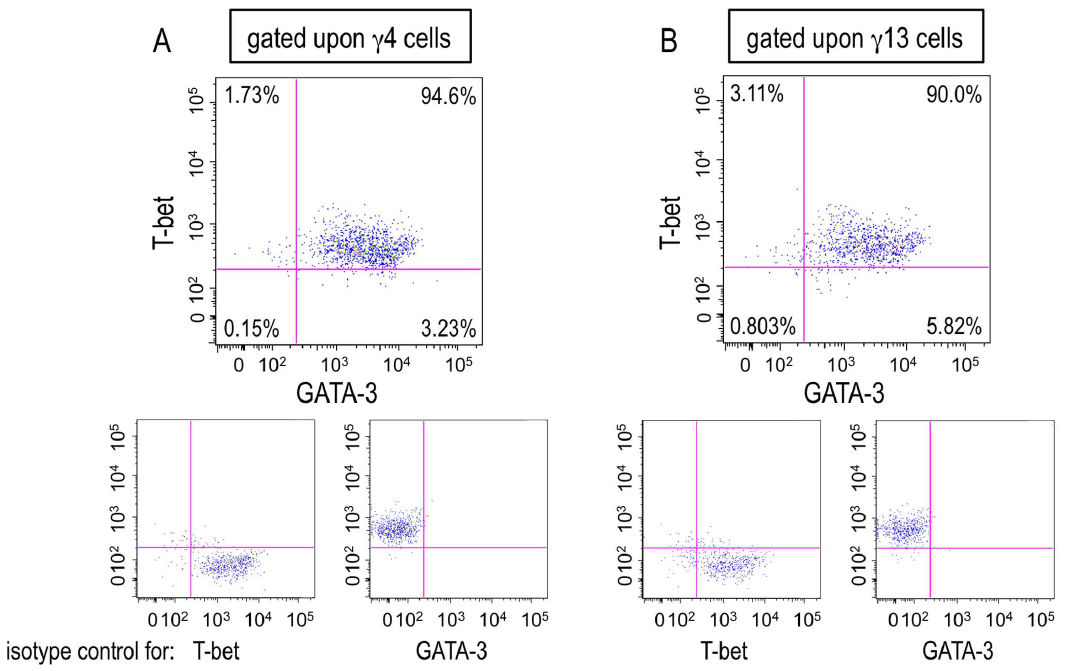
Figure 8. Both T-bet and GATA-3 were expressed in a single hepatic c 4 or c 13 cell. (A and B) Hepatic lymphocytes were isolated from S. mansoni -infected mice and the expressions of T-bet and GAT-3 were analyzed by flowcytometry after TCR stimulation at 6 weeks PI. The numbers in the upper, large insets represent percentages of each population divided by the expressions of T-bet and GATA-3 in c 4 (A) or c 13 (B) cells. The lower, small insets represent the data using isotype control antibodies. Similar results were obtained in three independent experiments.